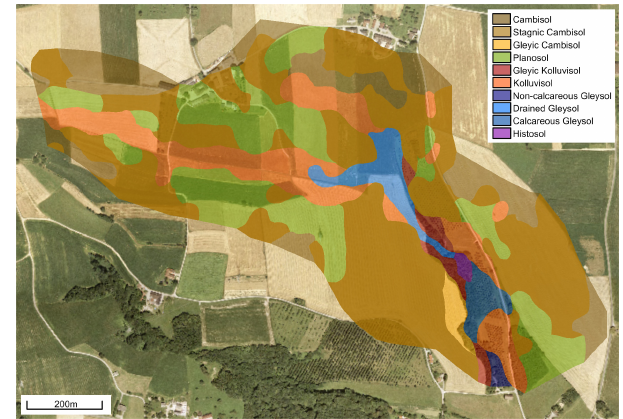
Figure 4. Soil types in the HOAL.